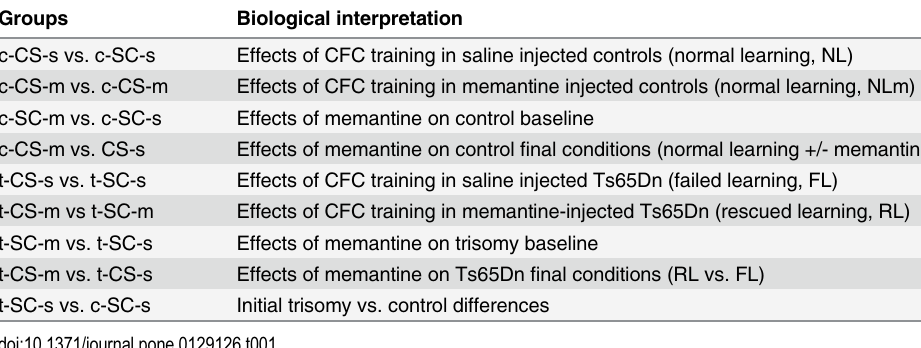
Table 1. Group comparisons and biological relevance.